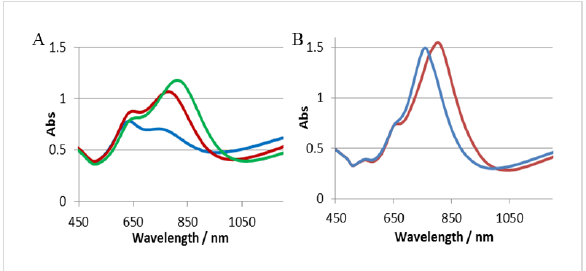
Figure 6: A) Extinction spectra of 110 nm PS particle gold cap/hole array with a gold film thickness of 30 nm where samples were not heated (blue) or post-heated to 116 °C (red) or 125 °C (green). B) Simulations of the non-heated structure in 6a (Blue) and with the cap lowered 10 nm